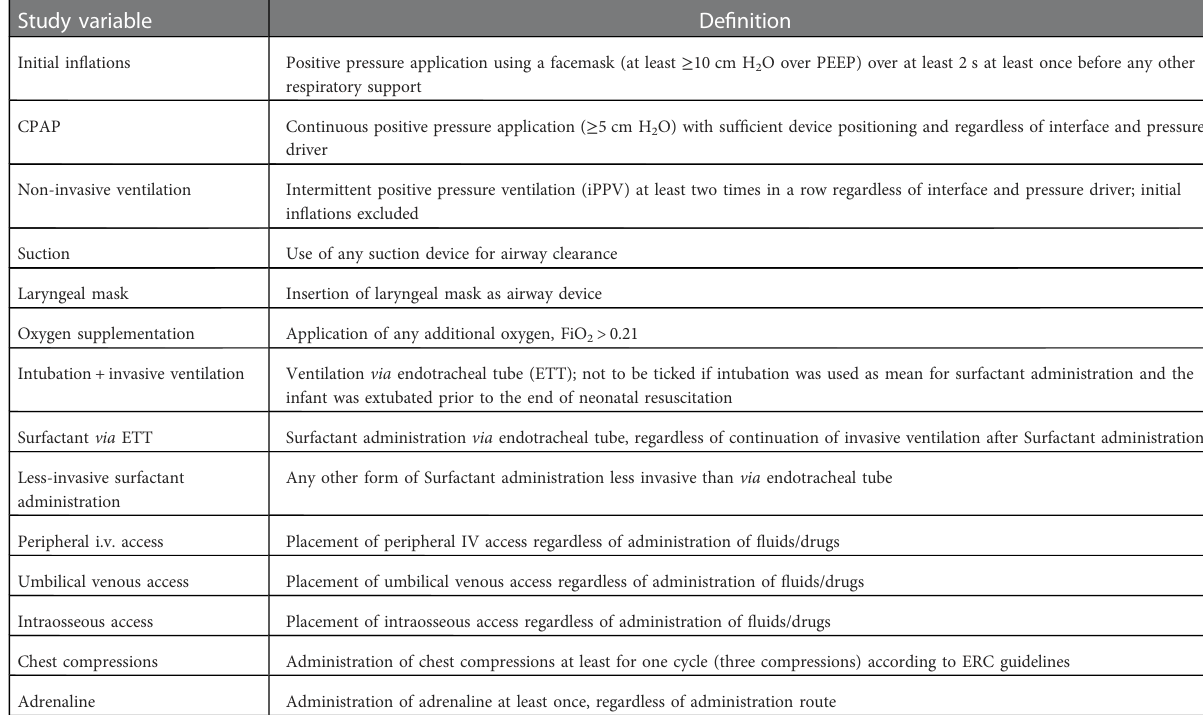
TABLE 1 De fi nitions of study variables/data collection form